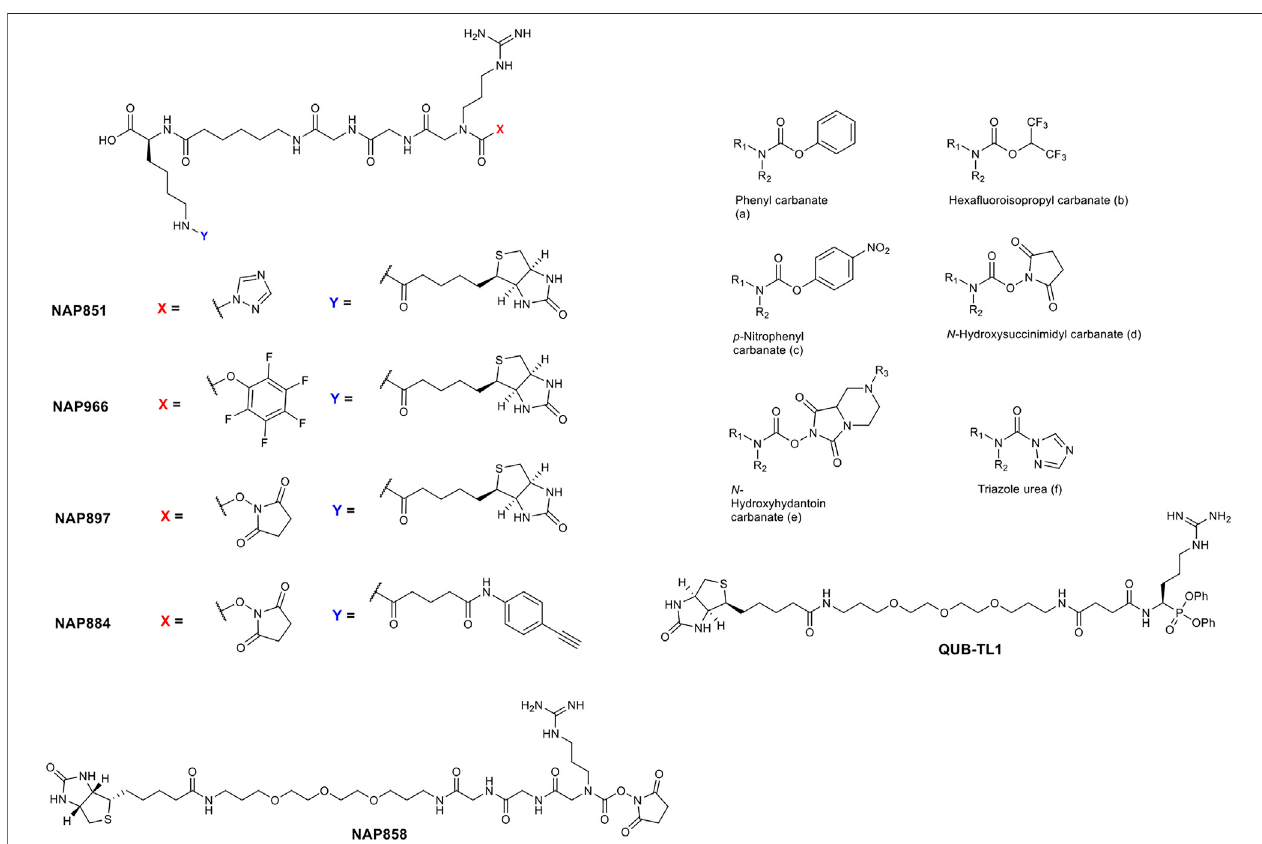
FIGURE 3 | Comparison of the structures of arginine N -alkyl glycine triazole urea and carbamate analogues synthesised in the present study, with previously reported triazole urea and carbamate (A – F) inhibitors of the serine hydrolases. The structure of the arginine diphenyl-phosphonate analogue (QUB-TL1), a previously reported activity probe for TLPs (Reihill et al., 2016) is also